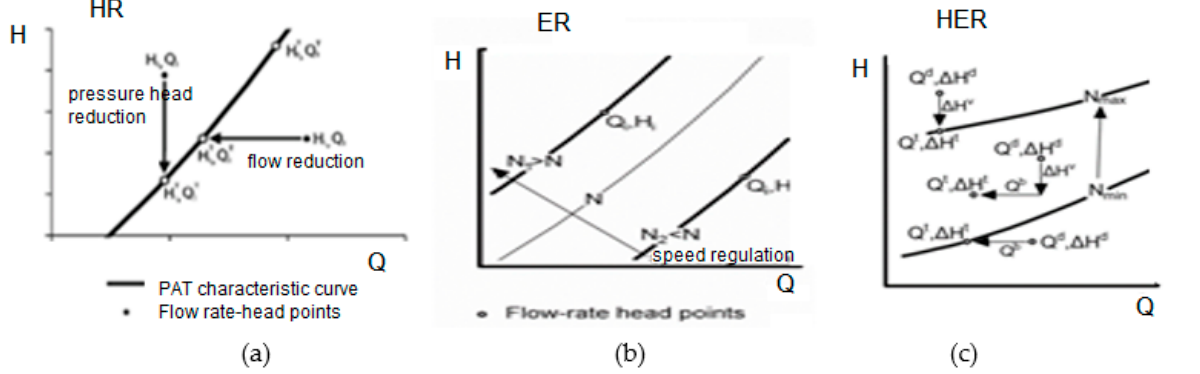
Figure 19. Hydraulic regulation (HR) and the effects of the regulation system ( a ); electric regulation (ER) and the corresponding characteristic curve changes ( b ); hydraulic and electric regulation (HER) ( c ).